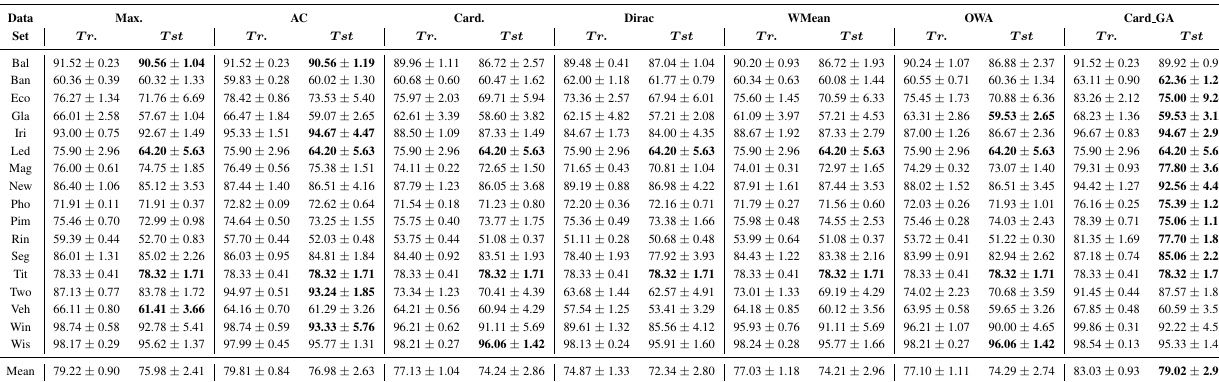
Table 3. Results in training (Tr.) and testing (Tst.) along with their standard deviations achieved by the seven approaches considered in this